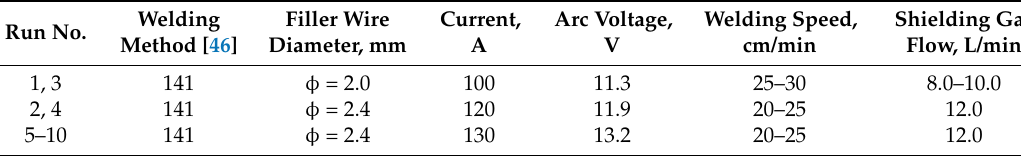
Table 3. Technological parameters of test joints fabrication.